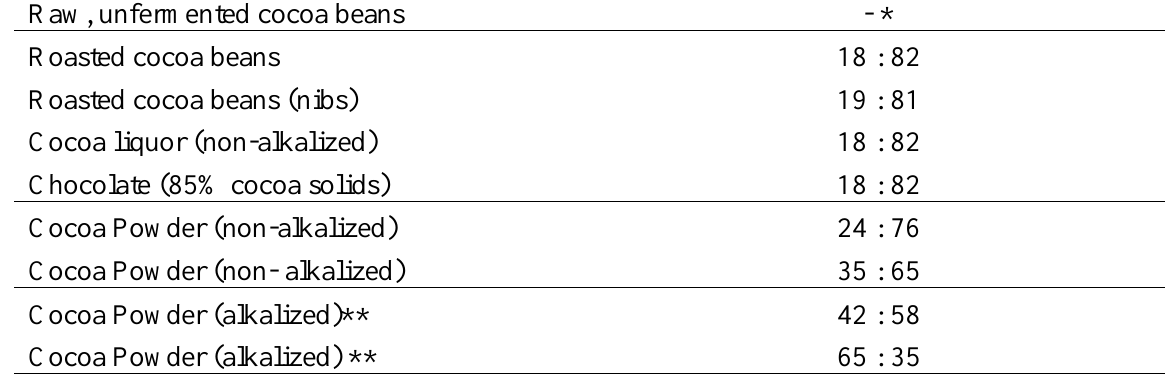
Table 1 . Peak ratios of (-)-catechin and (-)-epicatechin for the enantioselective separation of catechin and epicatechin in different cocoa and cocoa product